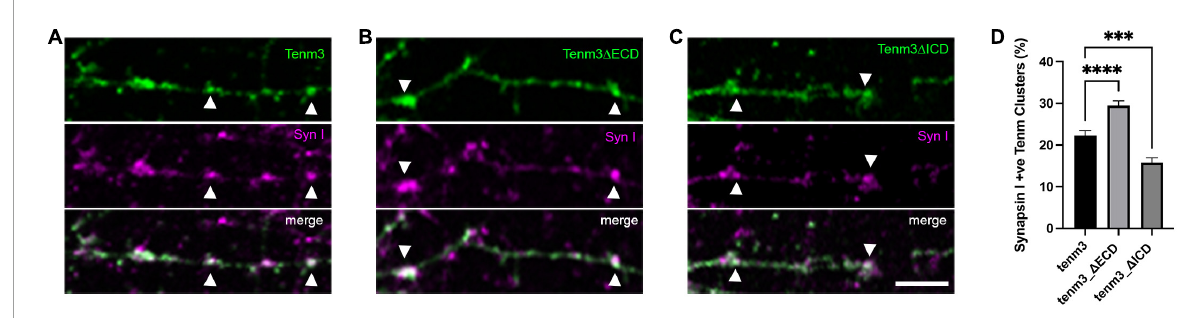
FIGURE4 The intracellular domain of Tenm3 drives protein localisation to the synapse. Synapsin I immunostaining in dissociated cortical cells overexpressing (A) full-length, (B) ECD-deleted (Tenm3 (cid:49) ECD), and (C) ICD-deleted (Tenm3 (cid:49) ICD) variants of EGFP-tagged Tenm3 showing punctate expression for all cases. Arrow heads show two example for co-localisation in each panel. (D) Quantification of co-localisation with Tenm3 (cid:49) ECD showing significantly higher (**** p < 0.0001), and Tenm3 (cid:49) ICD significantly lower (*** p = 0.0004), co-localisation with synapsin I. Data represents mean ± SE based on samples with at least 37 cells/condition pooled from a least three different experiments. One-way ANOVA with Dunnett’s multiple comparison test was performed between all conditions ( p < 0.05). Scale bar, 5 µ m.